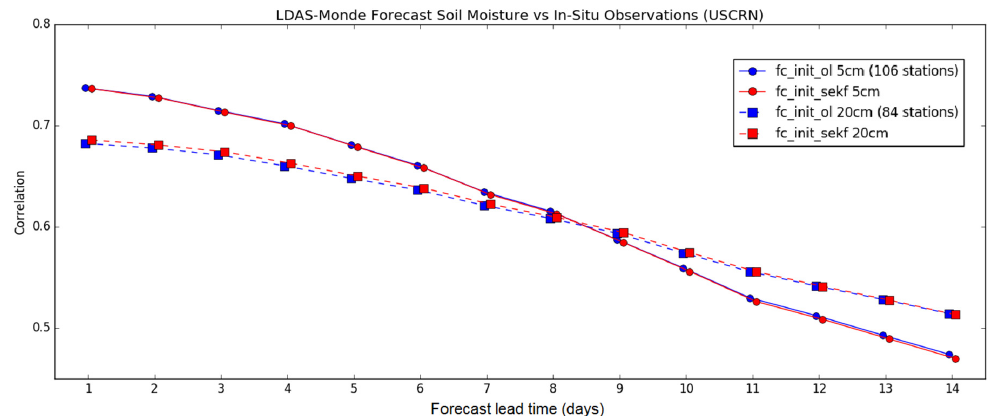
Figure 10. Correlations of OL ‐ (blue) and SEKF (red) ‐ initialized forecasts of SSM to USCRN in situ observations at 5 cm (circles) and 20 cm (squares). Due to the removal of freezing conditions and removal stations with less than 100 days of observations, the 5 cm correlations are averaged over 106 stations, whereas the 20 cm correlations are averaged over 84 stations.